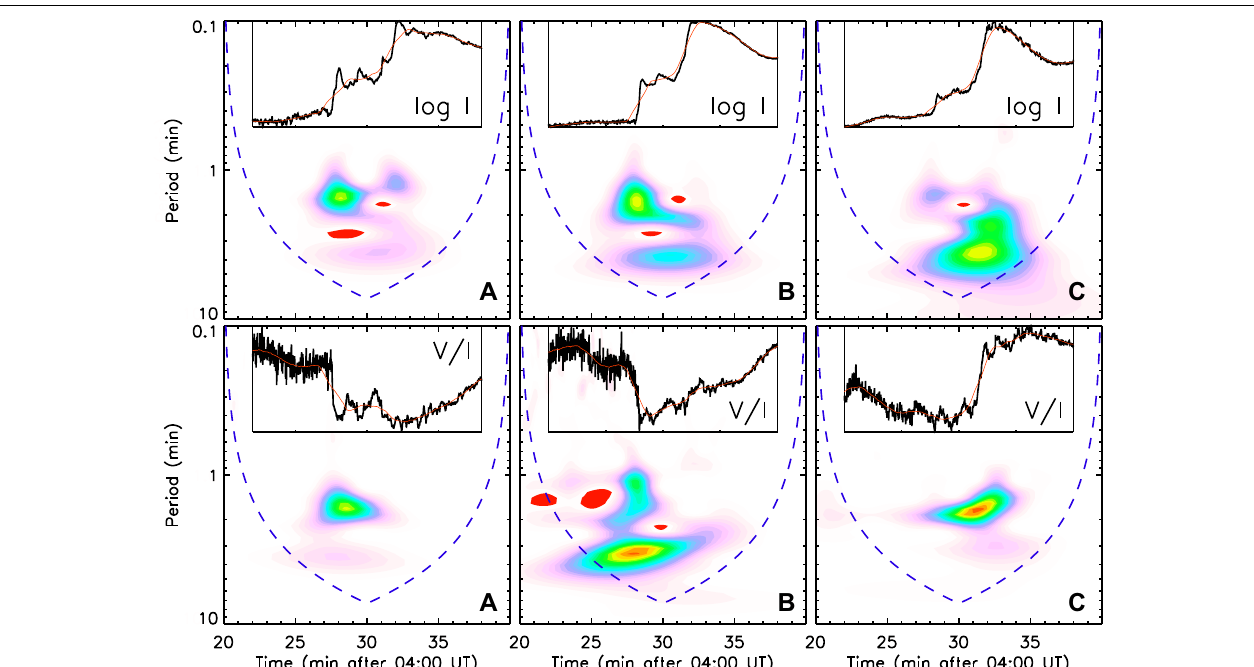
FIGURE 6 | Wavelet analyses of the total intensity (top panels) and degree of polarization (bottom) of 17 GHz emissions from three regions (A–C) (denoted in Figure 4A ). The inset in each panel shows the observed time profile (black line) and its running average (red). The difference between the two curves is used to produce the power spectral density (grayscale images) valid above the dashed blue line. Both the intensity and the power spectral density are plotted with the same time axis. (Source: Lee et al., 2020c).